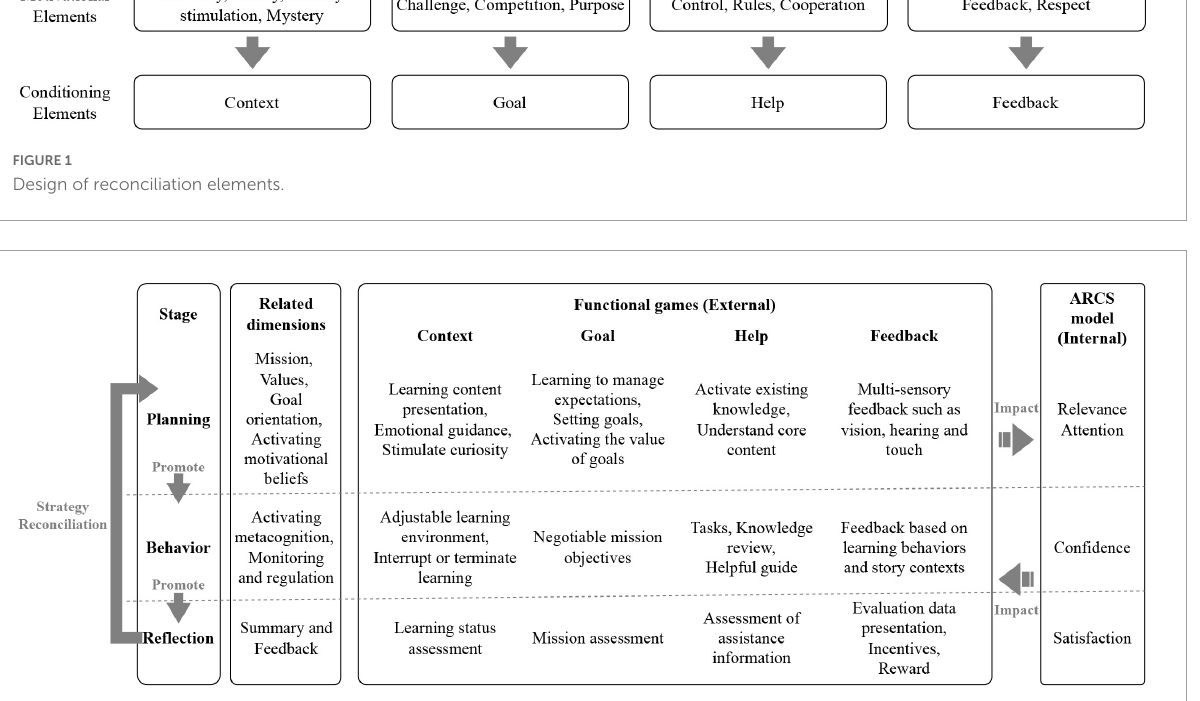
FIGURE2 Design of educational game strategies based on self-regulated